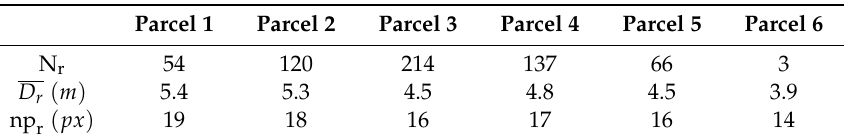
Table 3. Specifications of the reference